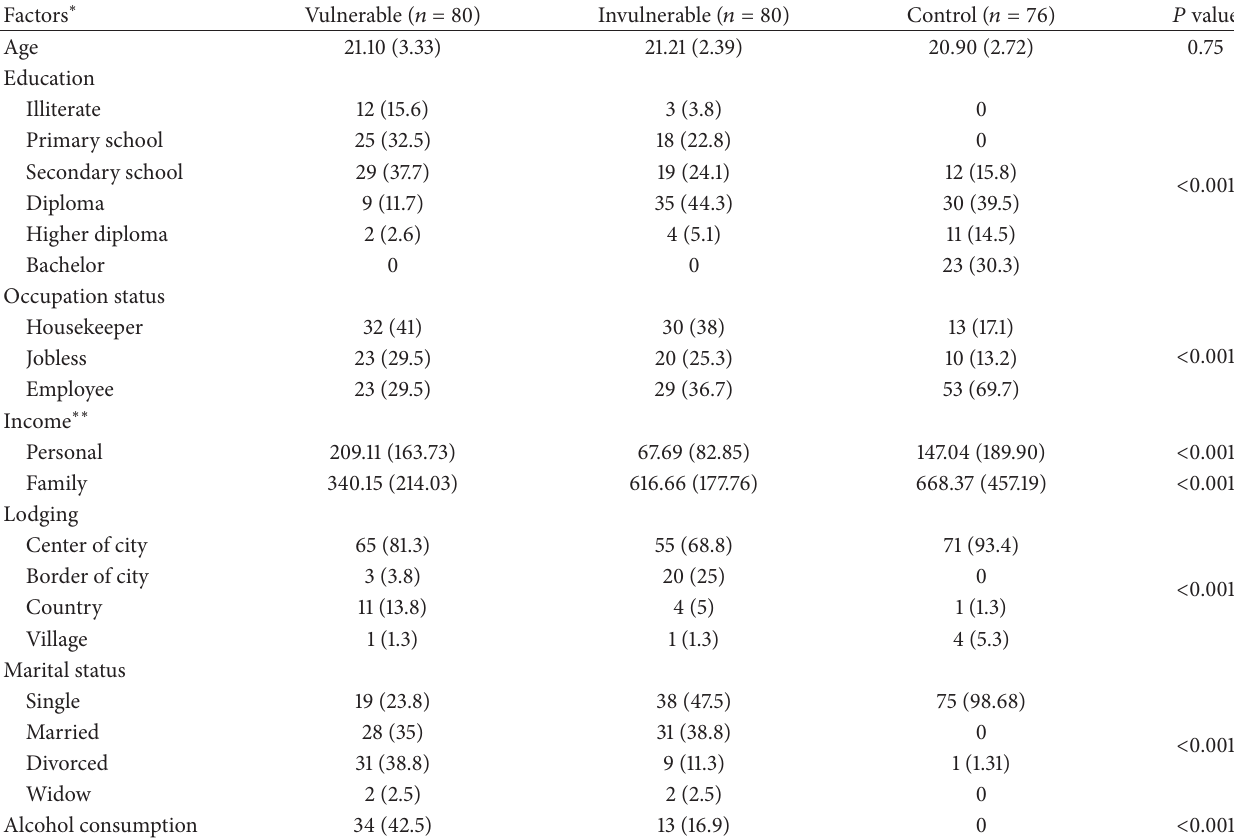
Table 1: Comparing demographic and social characteristics of three